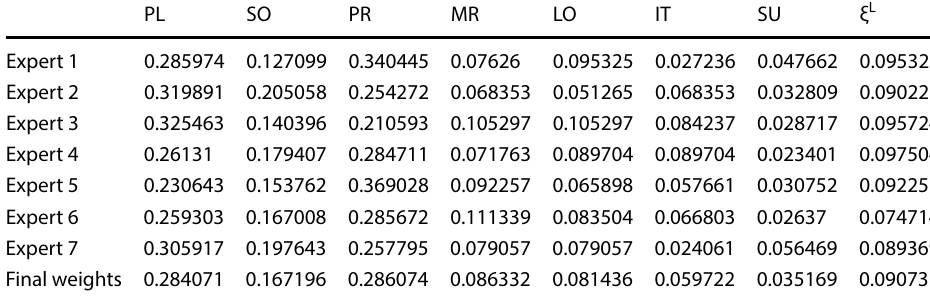
Table 4 Major risk elements